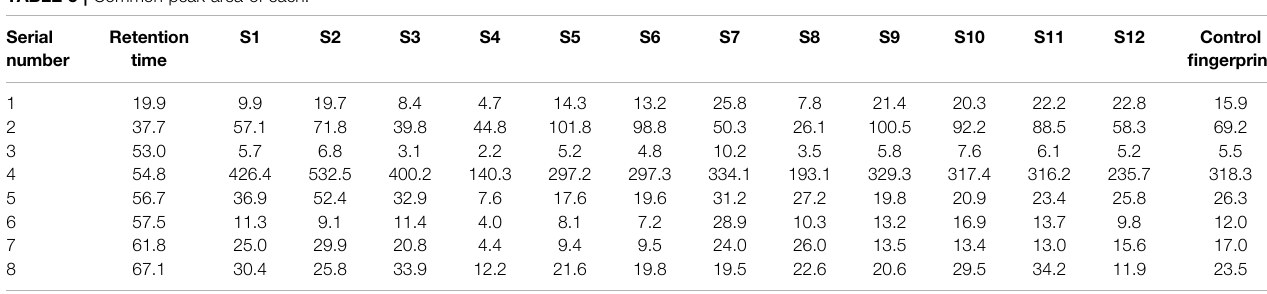
TABLE 5 | Common peak area of each.